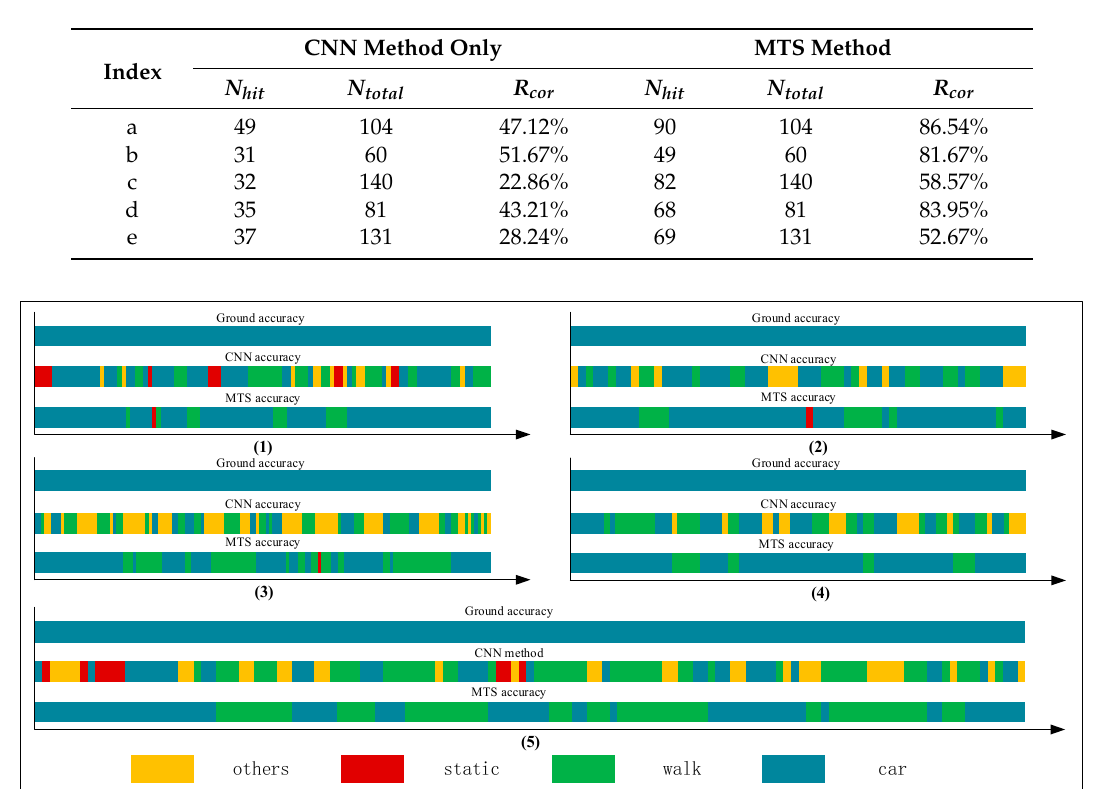
Figure 14. Graphs showing recognition of the walking state. Table 6. Recognition results for the in-car state. Table 6. Recognition results for the in-car state.